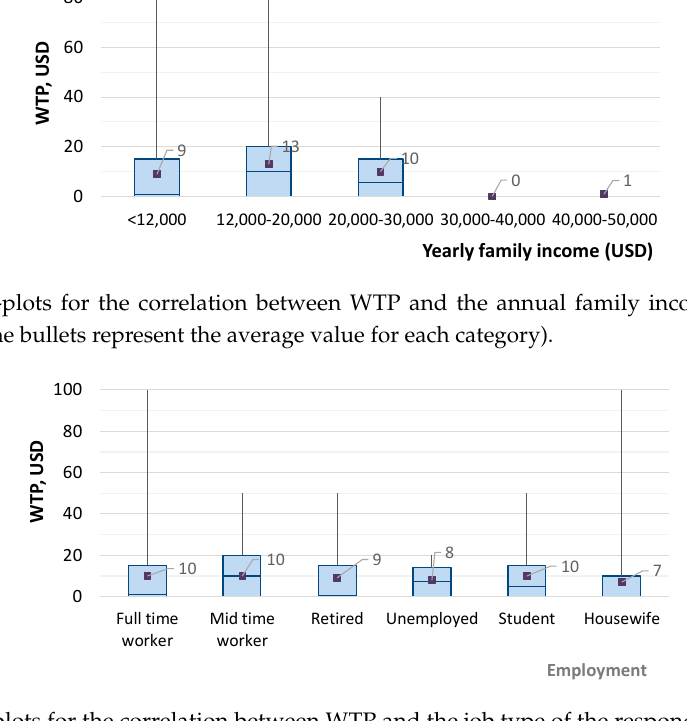
Figure 9. Box-plots for the correlation between WTP and the job type of the respondents (the bullet represents the average value for each category).